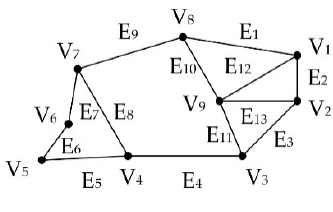
Figure 4. A weighted graph.